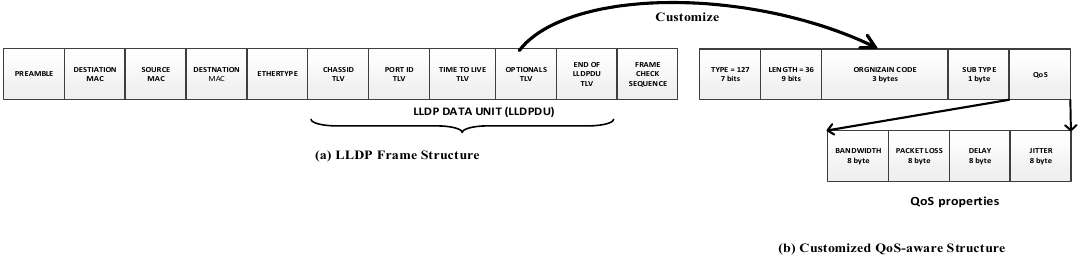
Figure 6. LLDP packet format for quality of service (QoS) monitoring.